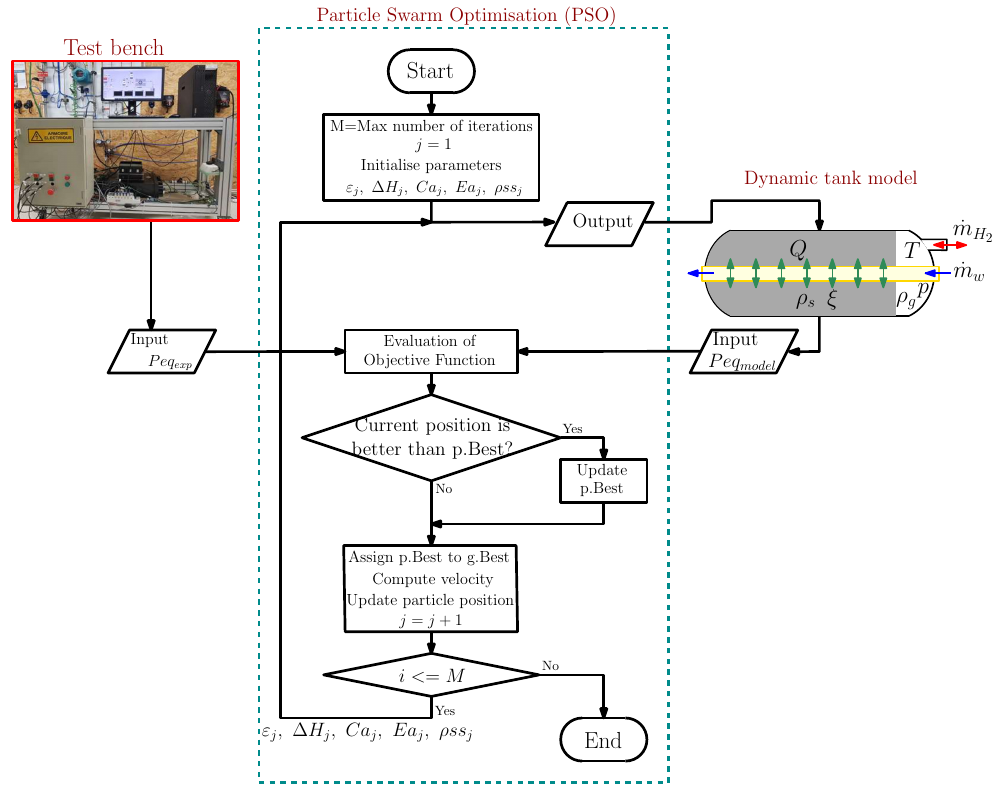
Figure 4. Diagram of physical parameter